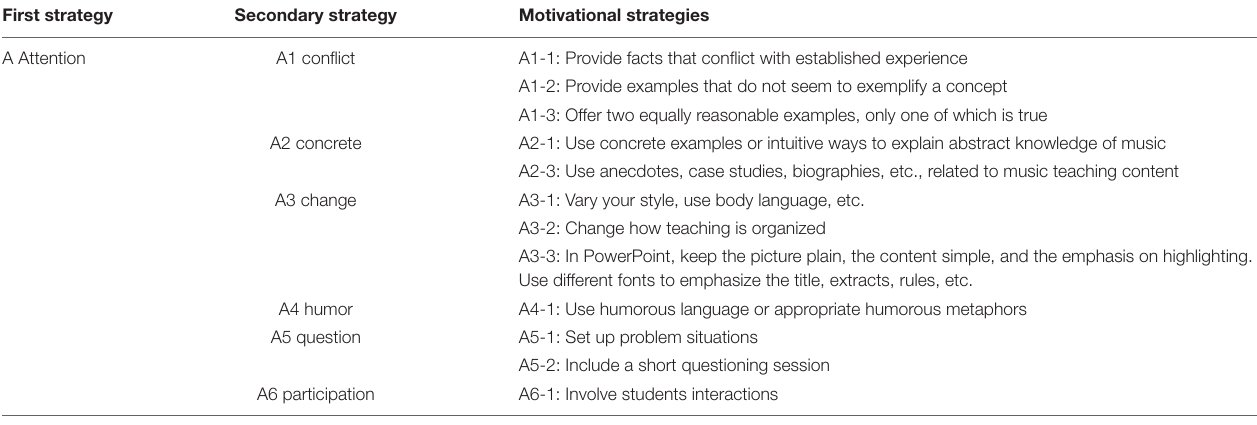
TABLE 1 | Attention strategy coding system after optimization.